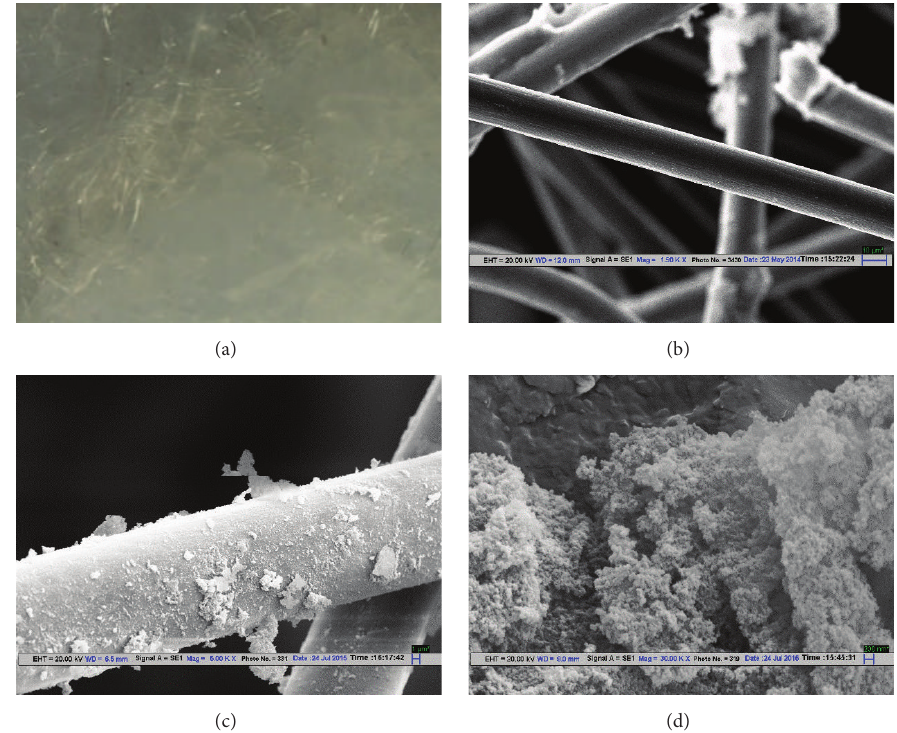
Figure 2: Microscopic view and SEM of an aerogel blanket: (a) ordinary microscopic image (30x), (b) Nomex fibrous batting (1.5Kx), (c) aerogel-fibre blanket (3.0Kx), and (d) aerogel in between the fibres